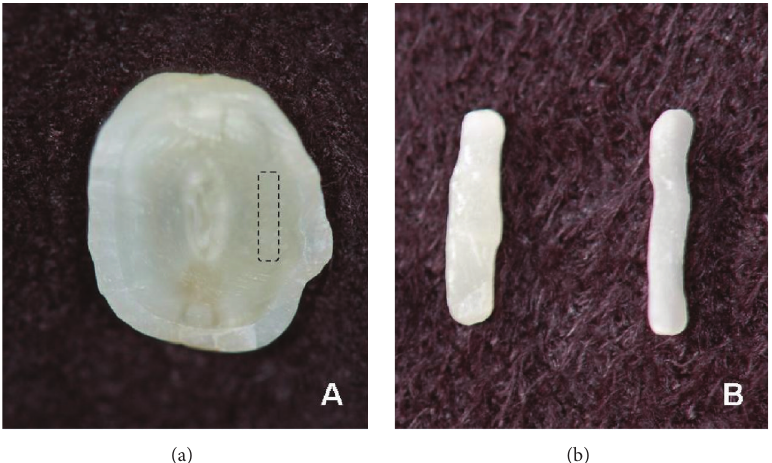
Figure 5: (a) Dental slice cut to obtain the dentinal pins, with outline showing the area from which they were obtained. (b) Dentinal